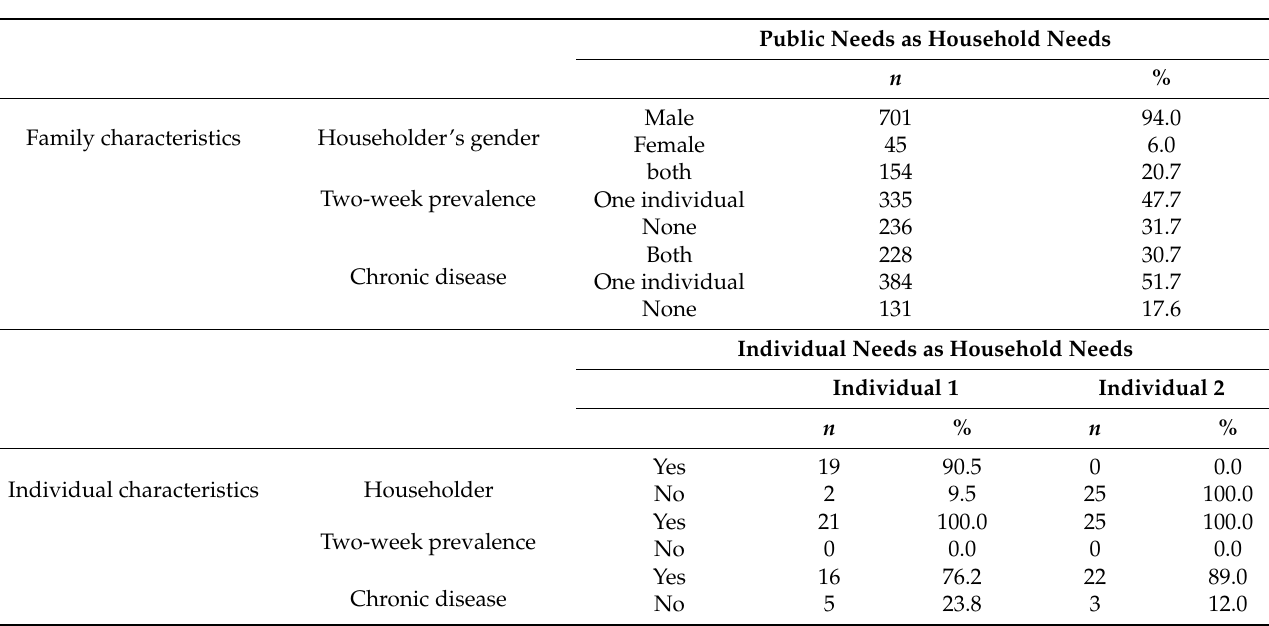
Table 4. Characteristics for health service needs in a household unit in empty nest households ( n ,